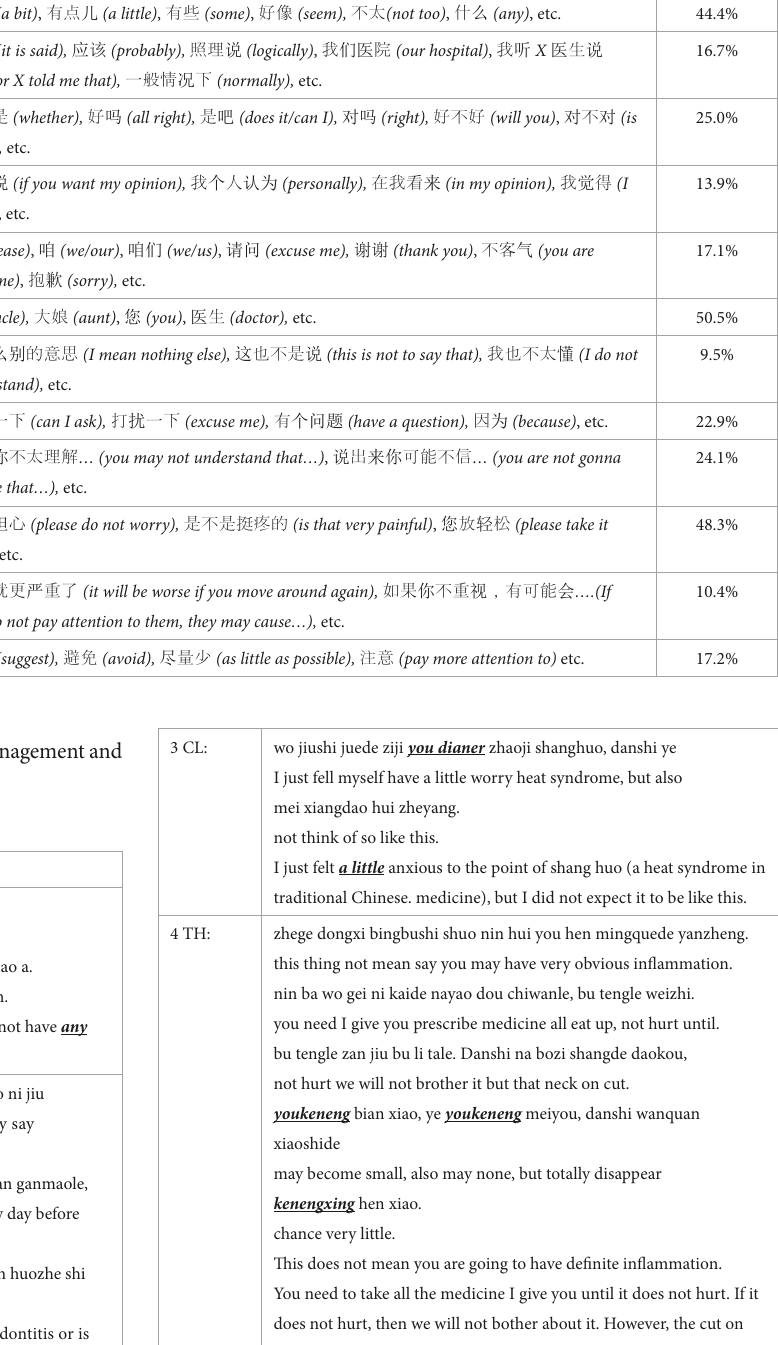
TABLE 1 Examples and ratios for therapist-client mitigation.